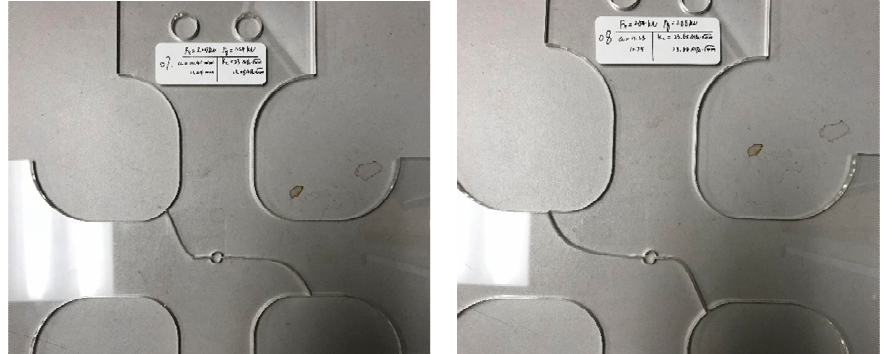
Figure 4. Scatter plot of (cid:1837) (cid:3030) : ( a ) with (cid:1827) (cid:3030) ( b ) with (cid:1846) (cid:3030) .